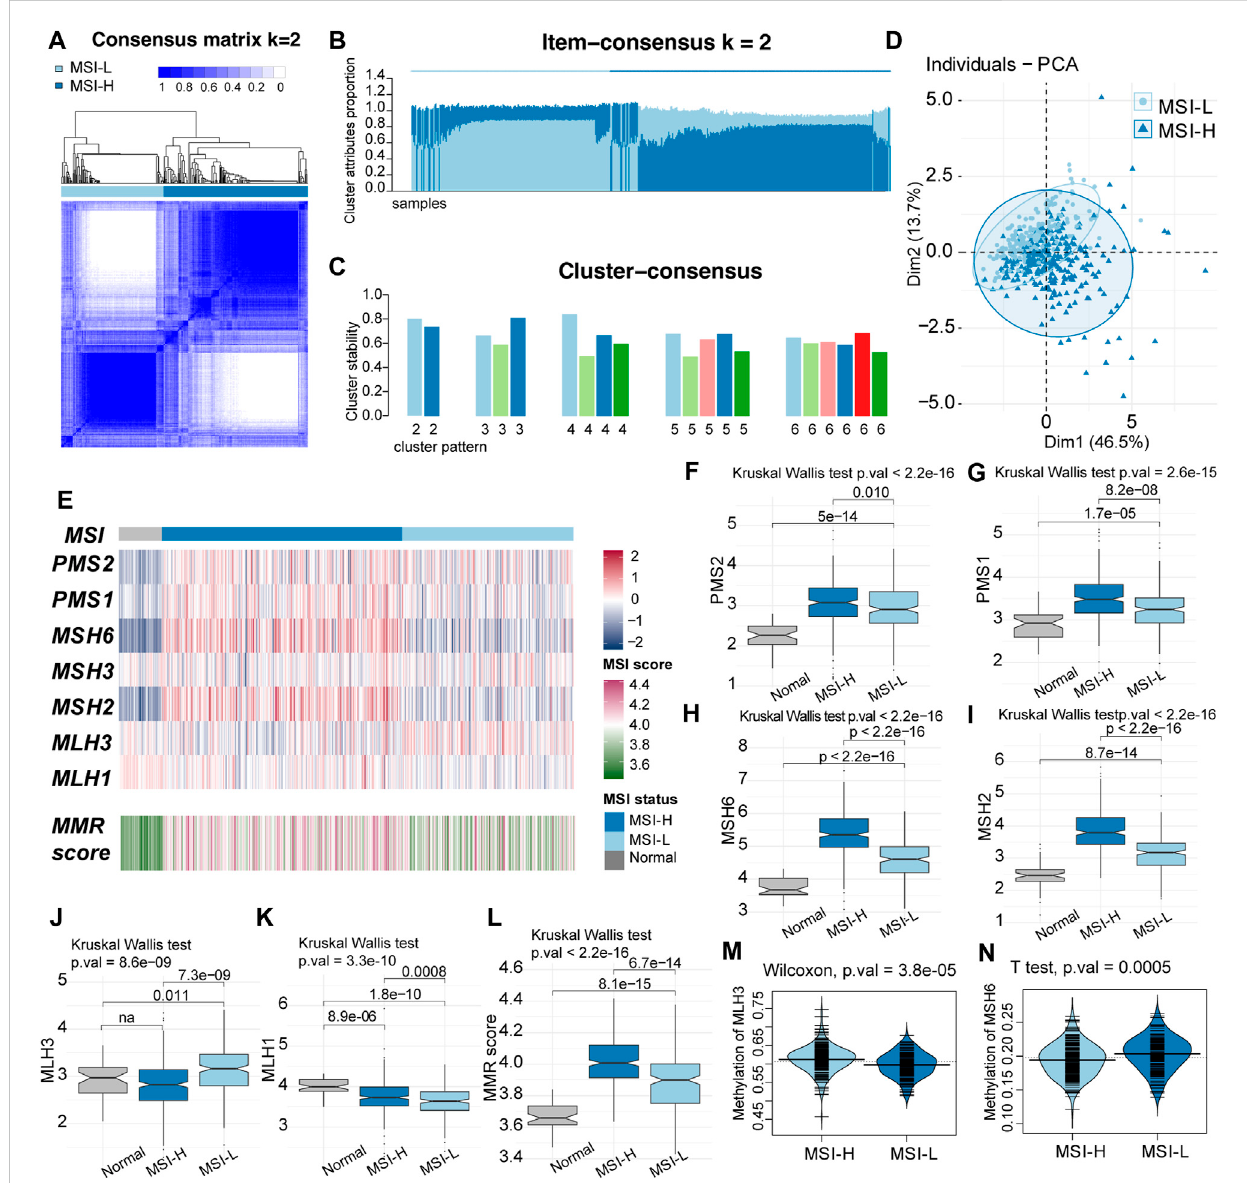
FIGURE 2 Two-group pattern of microsatellite instability (MSI) status by unsupervised classi fi cation in TCGA LUSC cohort. (A) Heatmap of consensus matrix whentheclassi fi cationpatternwastwo-group(k=2). (B) Item consensus plotwhenk=2showed thattheclusterpatternshared theacceptable purityin both groups. (C) Cluster consensus plot when k = 2 indicated the stability of the cluster patterns. (D) Principal component analysis (PCA) plot when k = 2 with196samplesinMSI-Lgroupsand276samplesintheMSI-Hgroup. (E) ComparationoftheMMRproteinsexpressionandtheMSIscorebetween MSI-H and MSI-L groups. MSI-H tended to had higher expression of MMR proteins and MSI score. (F – K) Comparation of MMR proteins among MSI-H, MSI-Landnormalsamples. (L) BoxplotofMMRscore.MSIscorewasdecreasedfromMSI-Hsamplestonormalsamples(MSI-H > MSI-L > normal). (M – N) Beanplot of methylation level of MLH3 and